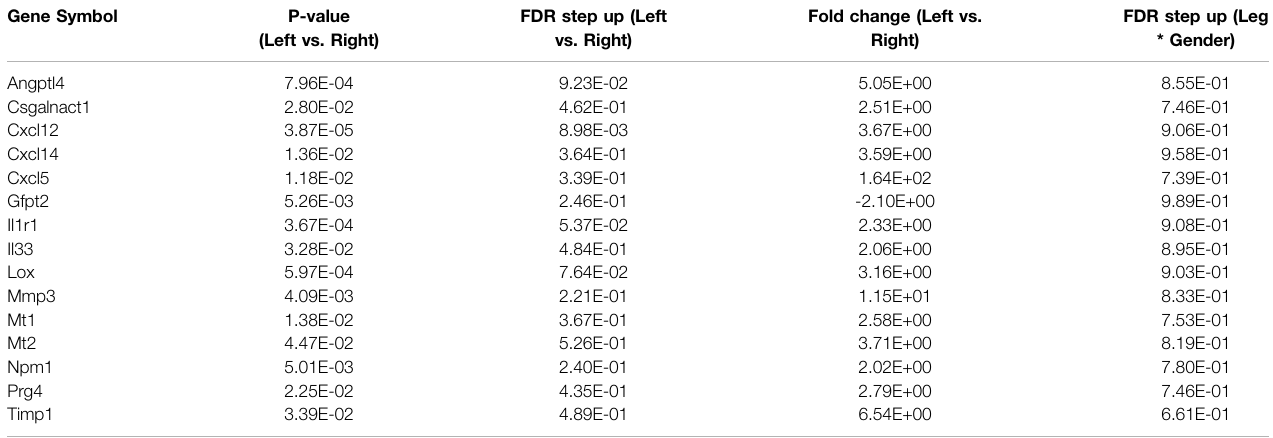
TABLE 3| Listofactivated FAPgenesfromRNA-seq data.Belowarethe fi fteen activatedFAPgenesfrom Table2 thatoverlappedwiththeRNA-seq data.Allbut onegene (Gfpt2) were upregulated signi fi cantly. Gene Symbol P-value FDR step up (Left Fold change (Left vs. (Left vs. Right) vs. Right)